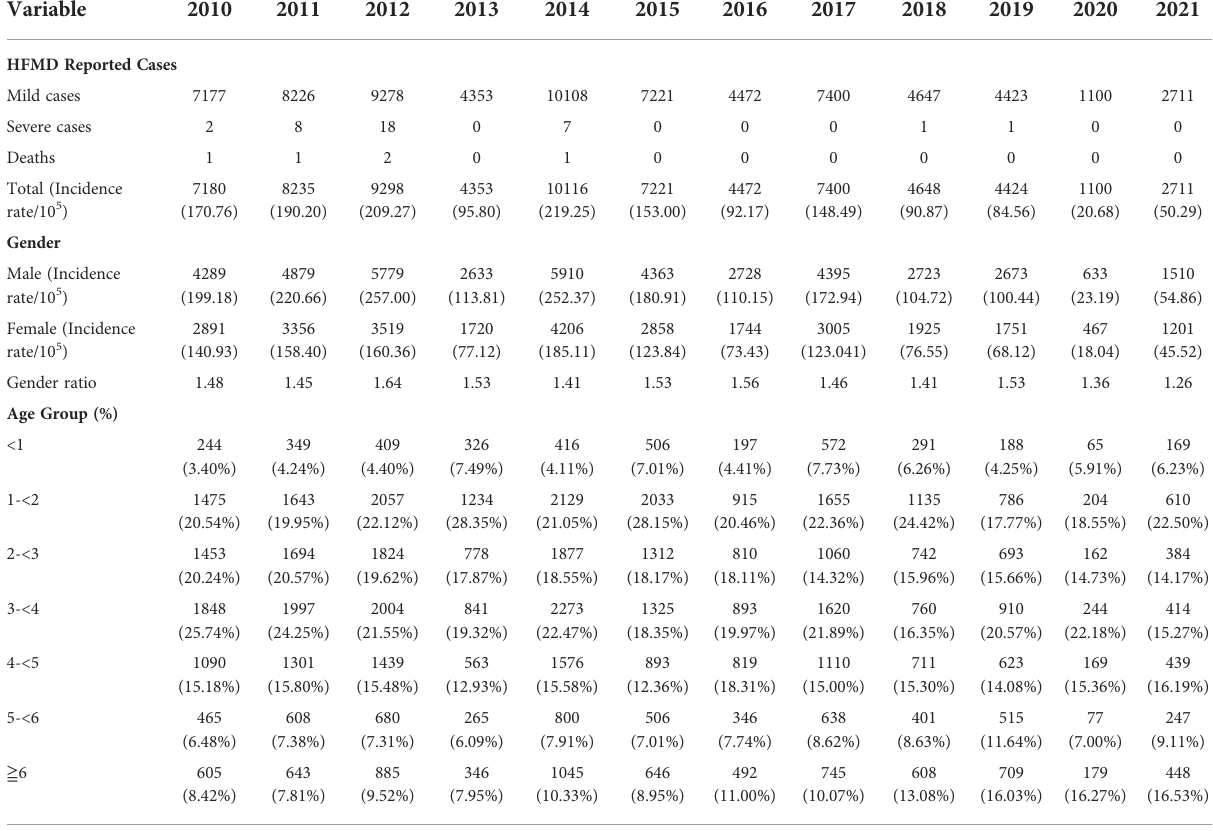
TABLE 2 Data of reported hand, foot, and mouth disease (HFMD) cases by gender, age group, and year.